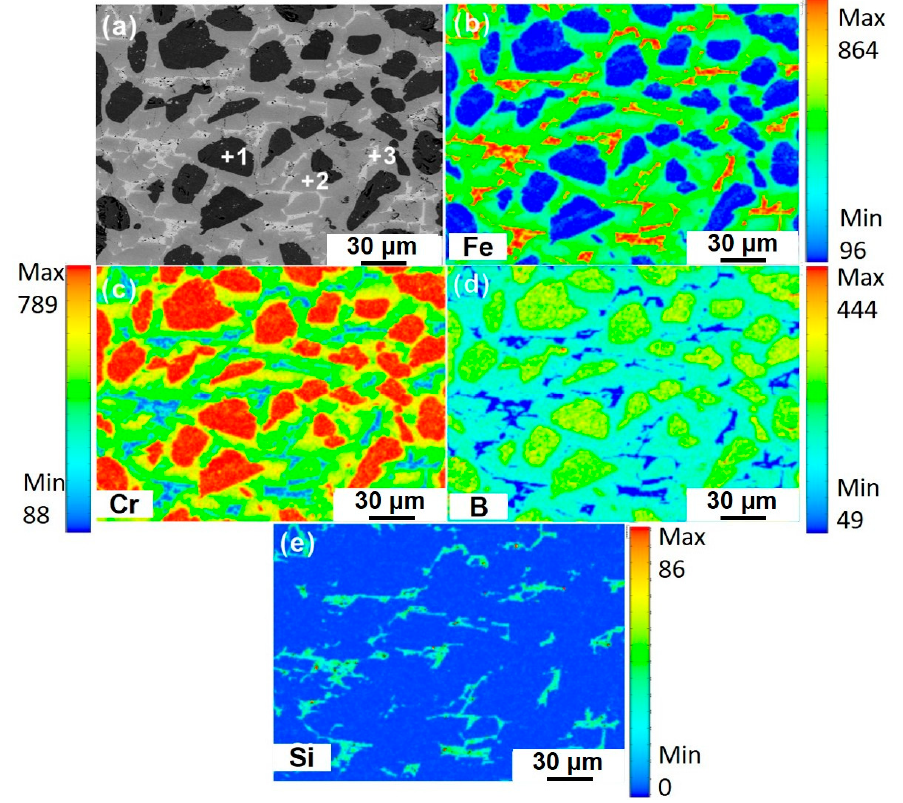
Figure 2. ( a ) The as-cast microstructure of the Fe-Cr-B alloy. ( b – e ) The electron probe microanalyzer (EPMA) elemental mappings of the as-cast microstructure.